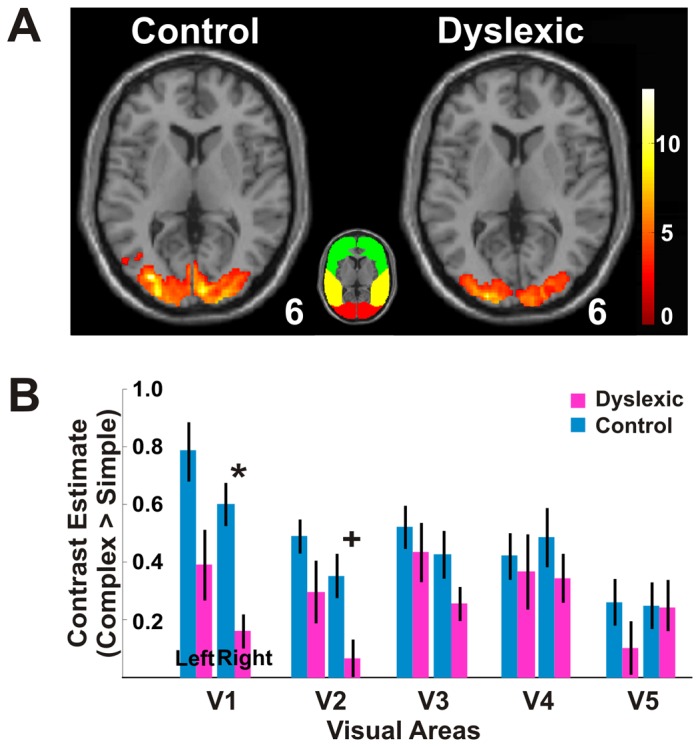
Activations in sensory regions.(A) The brain images illustrate occipital activation for control and dyslexic groups. For each image, the transverse slice shows voxels that exhibited a significantly greater activation for the complex condition than for the simple condition (Complex>Simple, p<0.05, cluster corrected for occipital lobe). The color bar depicts t values, and the color inset illustrates the subdivisions of occipital (red), temporal (yellow), and frontal (green) lobes. The number at the lower right corner of the transverse sections indicates that the images are taken at 6 mm above the AC–PC level. (B) Anatomically determined ROI analysis shows greater activation in visual areas V1, V2, V3, V4 and V5 for the control group (bars in blue) than for the dyslexic group (bars in red). +
p<0.10, *p<0.05, Bonferroni corrected t-test between groups. Error bars represent SEM within group.